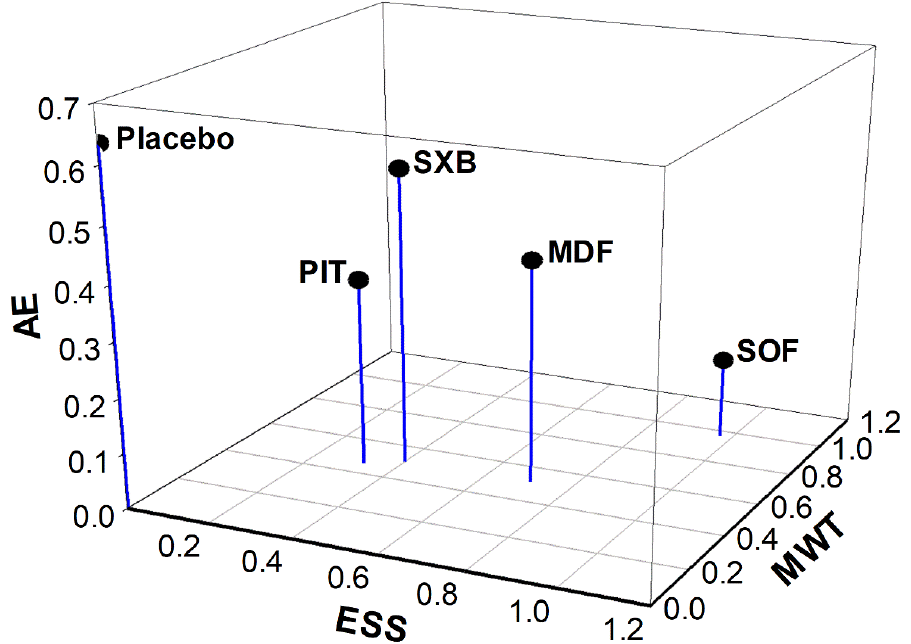
Figure 4. Three-dimensional clustered ranking plot converging P-scores of ESS change, MWT change, and AE for applicable interventions. ESS, Epworth Sleepiness Scale; MWT, Maintenance of Wakefulness Test; AE, adverse event; SOF, solriamfetol; MDF, modafinil; SXB, sodium oxybate; PIT, pitolisant. The X-, Y-, and Z-axis is ESS, MWT, and AE, respectively. Category of any AE that occurred to the participants was utilized to represent AE in the scatter plot. Length for interventions to origin of coordinates in planar (X-Y): SOF = 1.37; MDF = 0.87; SXB = 0.64; PIT = 0.56; placebo = 0.003. Length for interventions to origin of coordinates in 3D (X-Y-Z): SOF = 1.38; MDF = 0.96; SXB = 0.84; PIT = 0.66; placebo = 0.64.